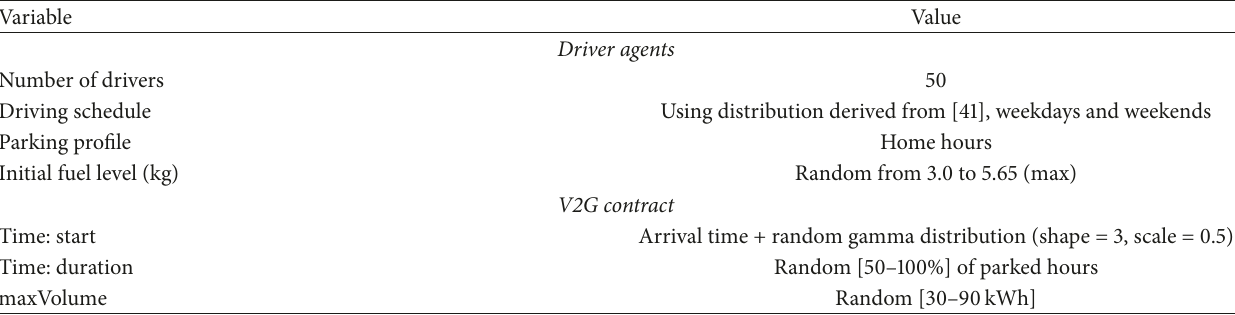
Table 6: Drivers and V2G contract